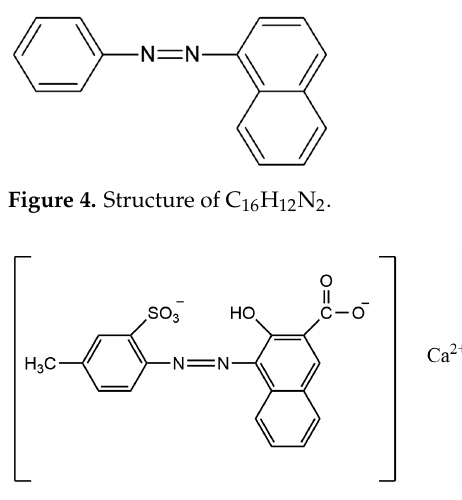
Figure 3. ( a ) IR spectrum of areas 4-a, 5-a, and 5-b and the magenta standard sample. ( b ) IR spectrum of areas 5-b and paper.